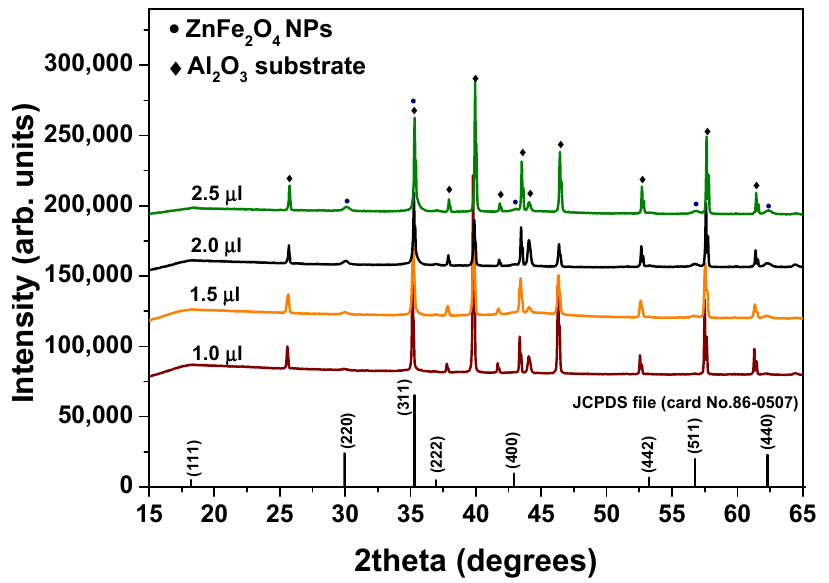
Figure 2. Diffraction patterns of the ZnFe 2 O 4 deposited sensing films at volumes of 1.0, 1.5, 2.0, and 2.5 µL.